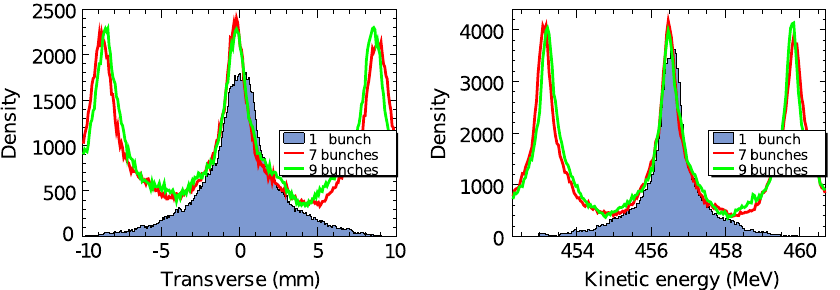
FIG. 12. (Color) Comparison of the histograms along the transversal direction in the local frame S (right) of 1 mA beam at the 112 (cid:6) azimuthal position of turn 130 in the PSI ring cyclotron.